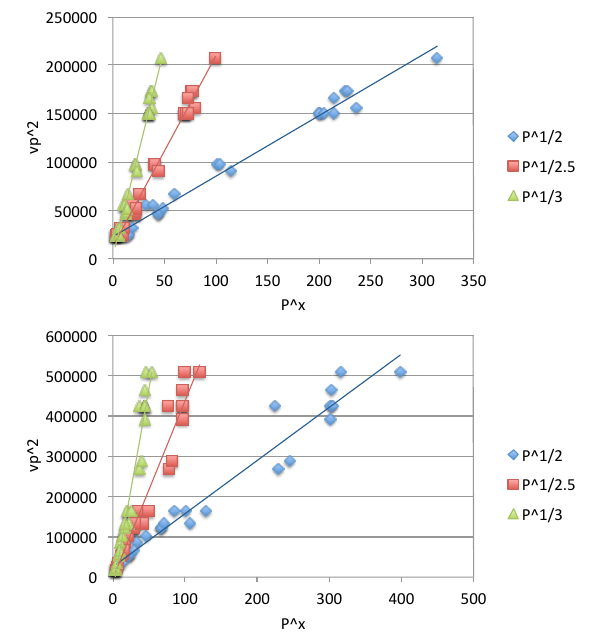
Figure 4. Squared speed of the P wave vs internal pressure elevated to the powers of 1 / 2, 1 / 2.5 and 1 / 3 (cohesionless simulations). RCP (top) and HCP (bottom)